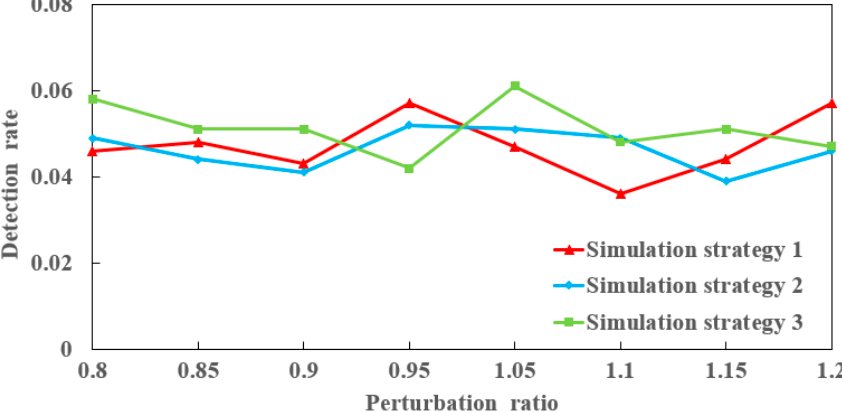
Figure 7. The detection rates in simulation strategies 1, 2, and 3 when the perturbation ratio increases from 0.8 to 1.2.